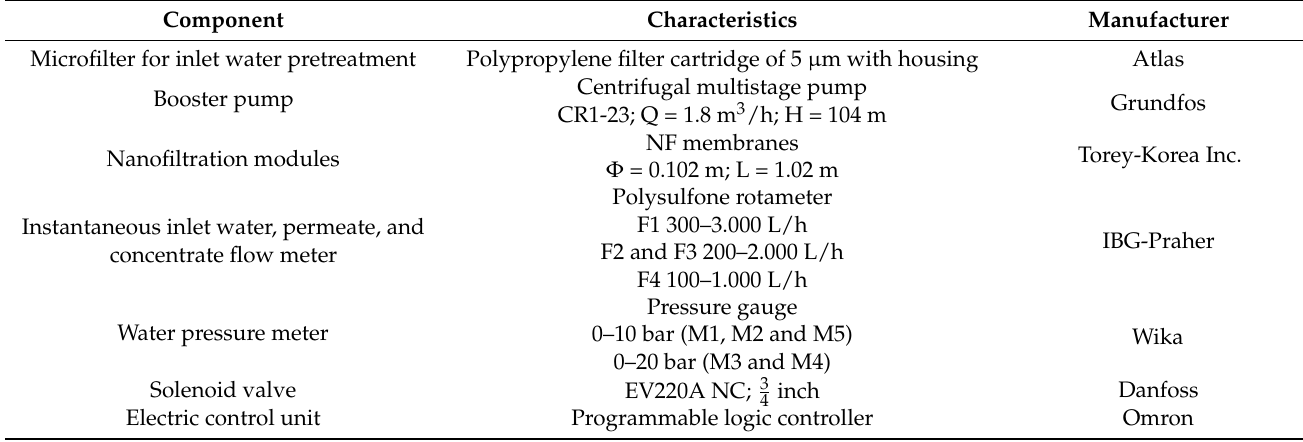
Table 2. Main components of nanofiltration pilot